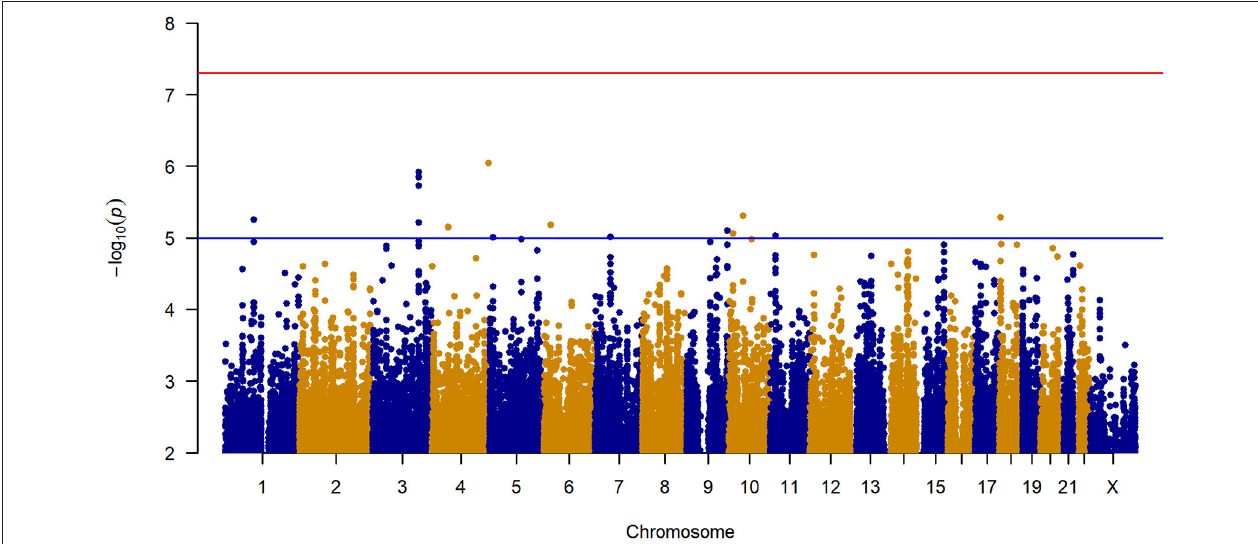
FIGURE 2 | Manhattan plot of GWAS of change in IBS-SSS among 188 IBS patients controlling for age, sex, treatment arm, and the first five principal components for genetic ancestry.